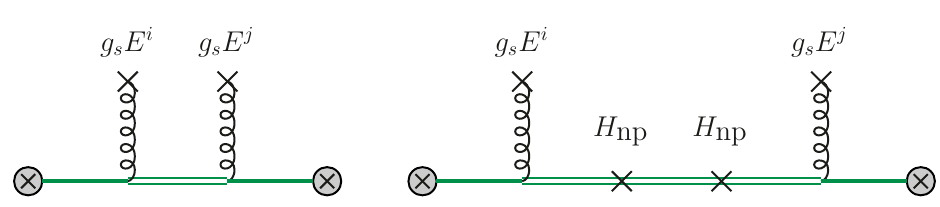
Figure 1 . Leading dimension four and six condensate contributions to the Green function. The single and double lines denote the LO color-singlet and color-octet Green functions,